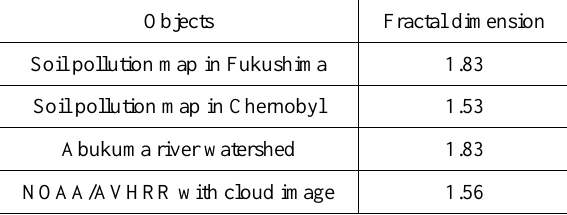
Table 2 Fractal dimensions f radioisotope pollutions